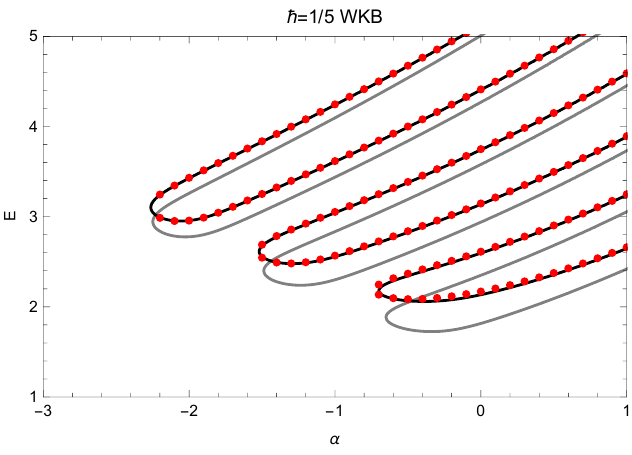
Figure 4 . The black lines show the curves satisfying the approximate EQC (3.47), in which U 0 , Y 0 are given by the gauge theory instanton expansion up to order (cid:3) 6 . In the gray lines, only the perturbative part (i.e. the very (cid:12)rst terms in the expansions (3.41), (3.42)) has been used. The red dots represent numerical values of the spectrum of the operator (3.21), obtained with complex dilatation techniques. Here ~ = 1 =